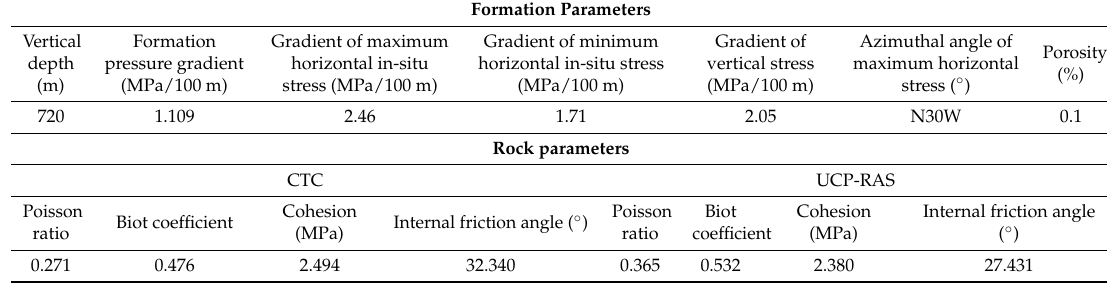
Table 4. Formation and rock parameters of the third coal seam.